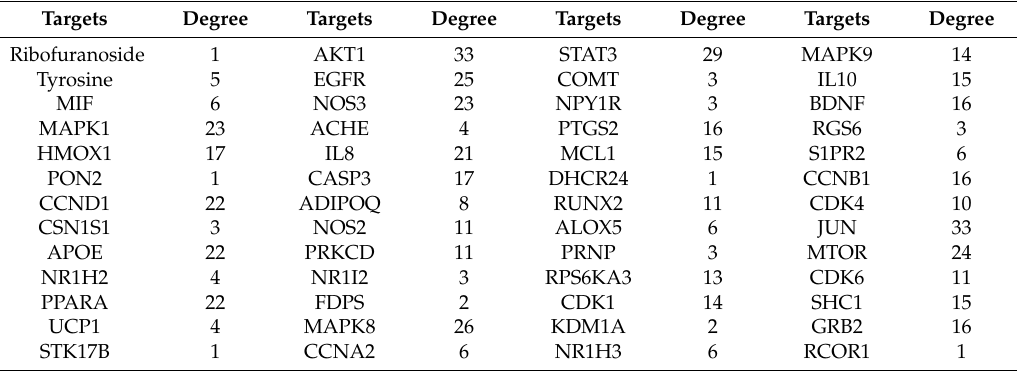
Table 1. Node degree of Tiansi Liquid targets obtained through STITCH.